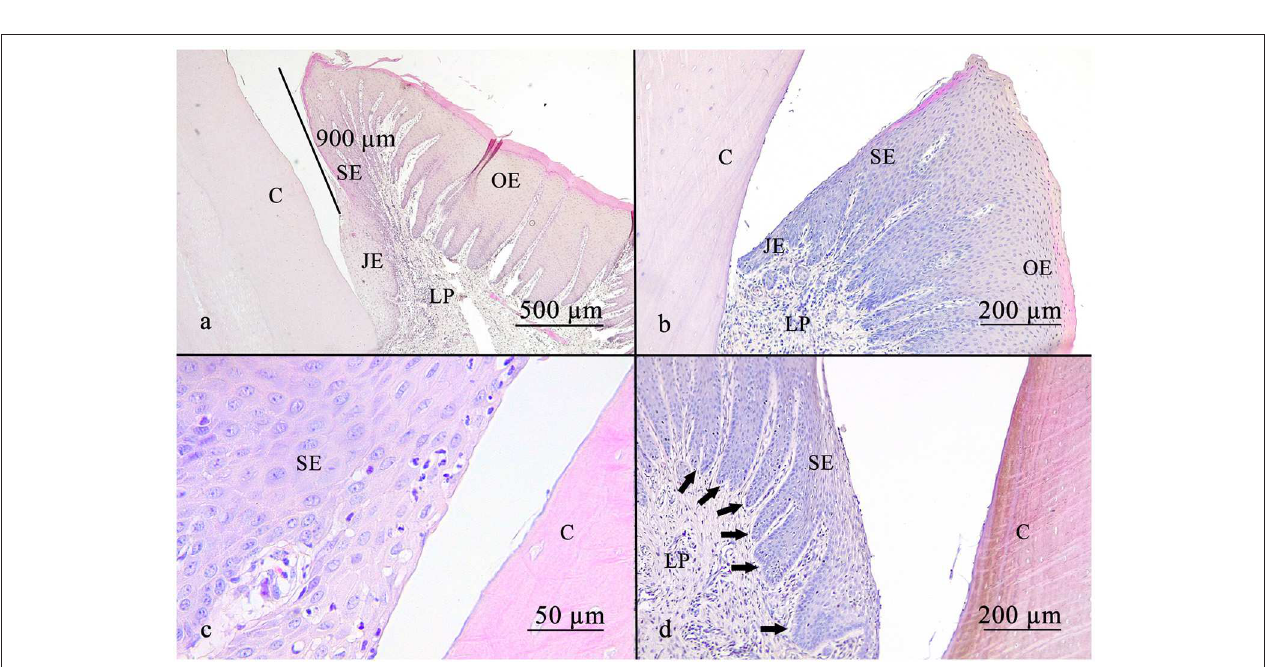
direction, approaching the dental surfaces, the number of epithelial cells decreased and adjacent to the dental surface a line of single cells attached the tooth, resembled a